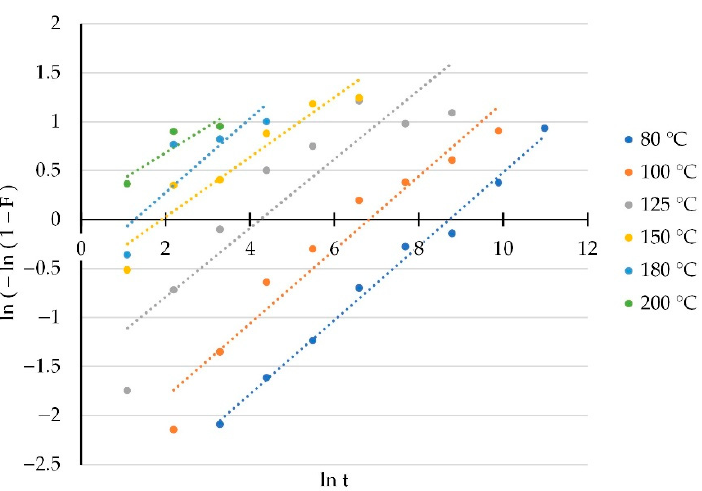
Figure 4. Johnson-Mehl-Avrami-Kolmogorov plots of proof stress (Ø0.71 wire, 80–200 °C).